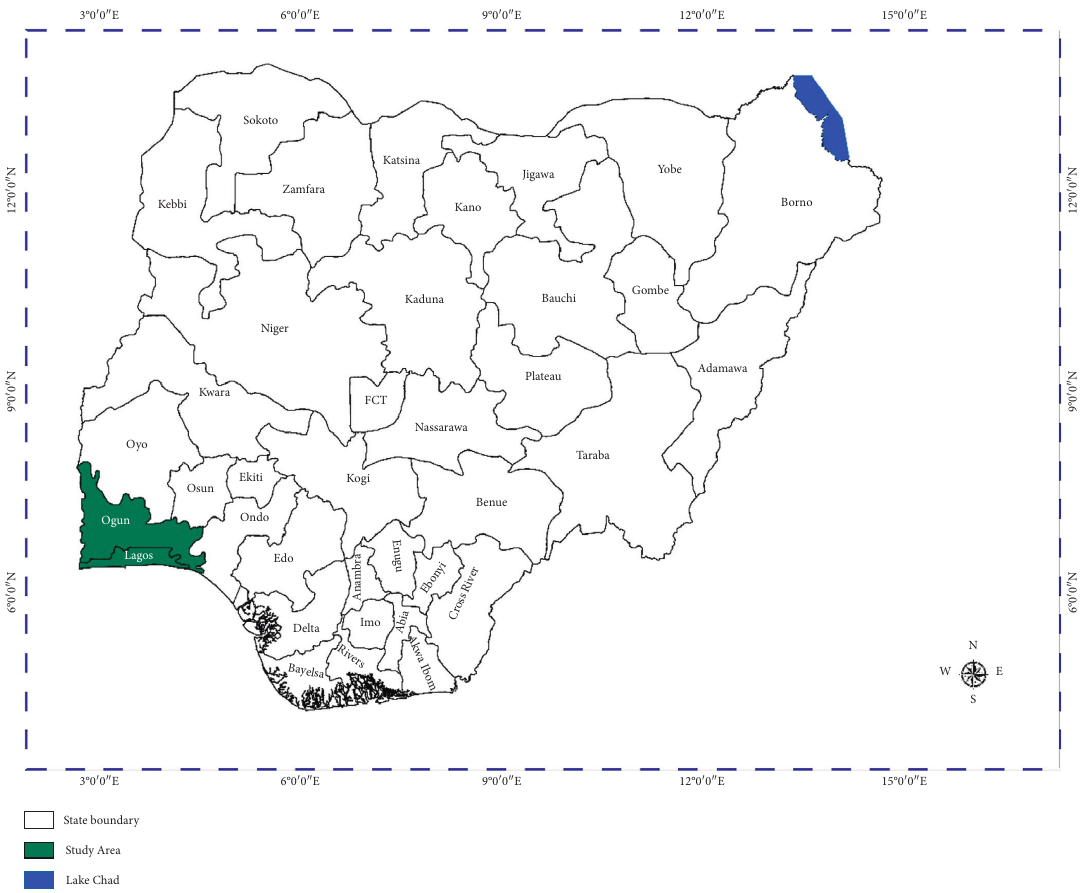
Figure 1: Map of Nigeria showing the study area. Table 1: Association between child’s age group, gender, and